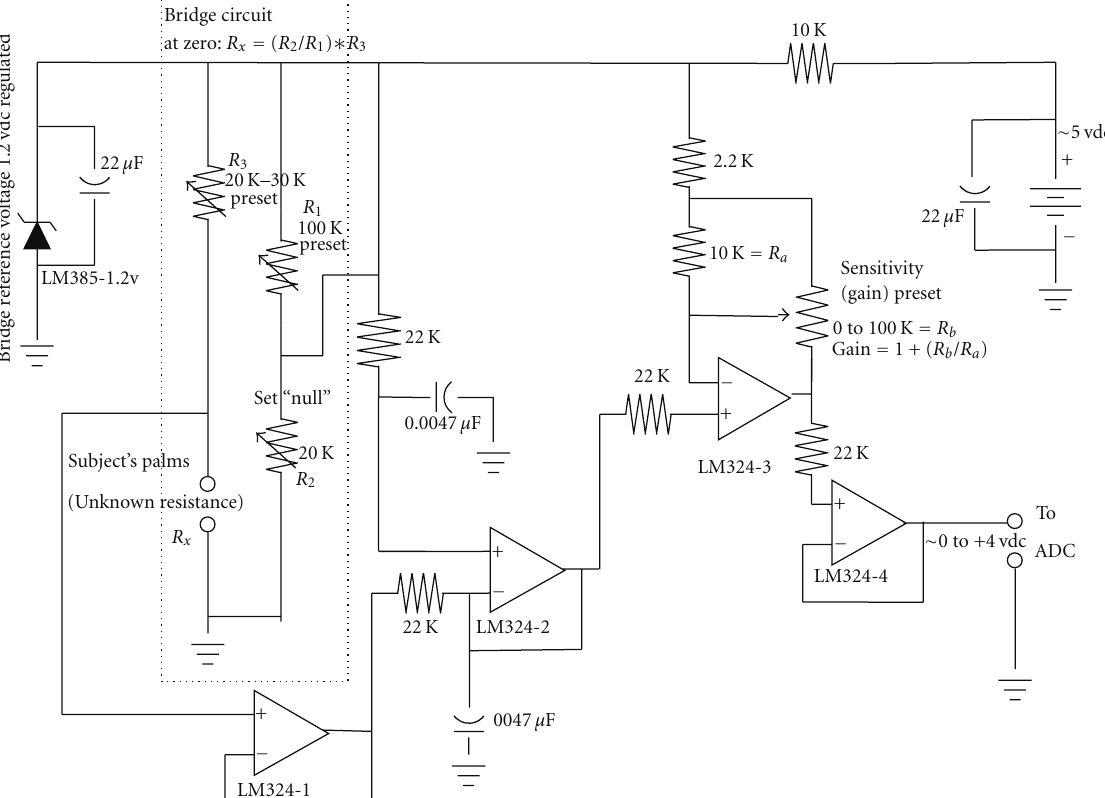
Figure 7: Schematic of analog feeder circuit to acquire a ff ective data stream and inject to DataQ DI-194RS, 10-bit, 240 Hz sample rate analog digital converter (ADC) using a Wheatstone bridge amplified by an LM324 op-amp (adapted from http://www.national